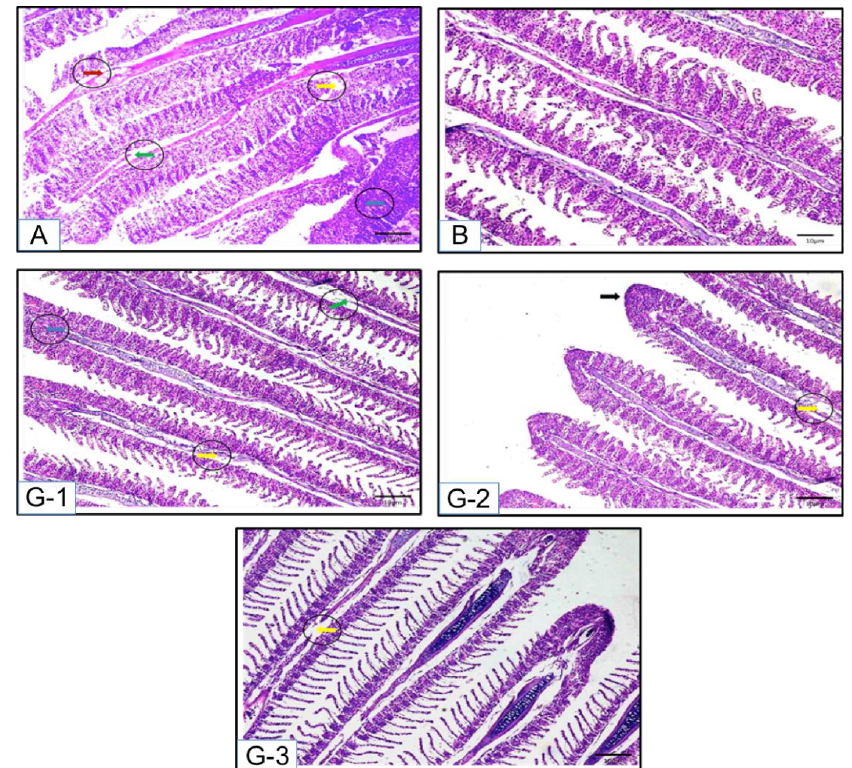
Figure 2. Photomicrographs (400×) of gills of the common carp ( C. carpio ) experimentally exposed